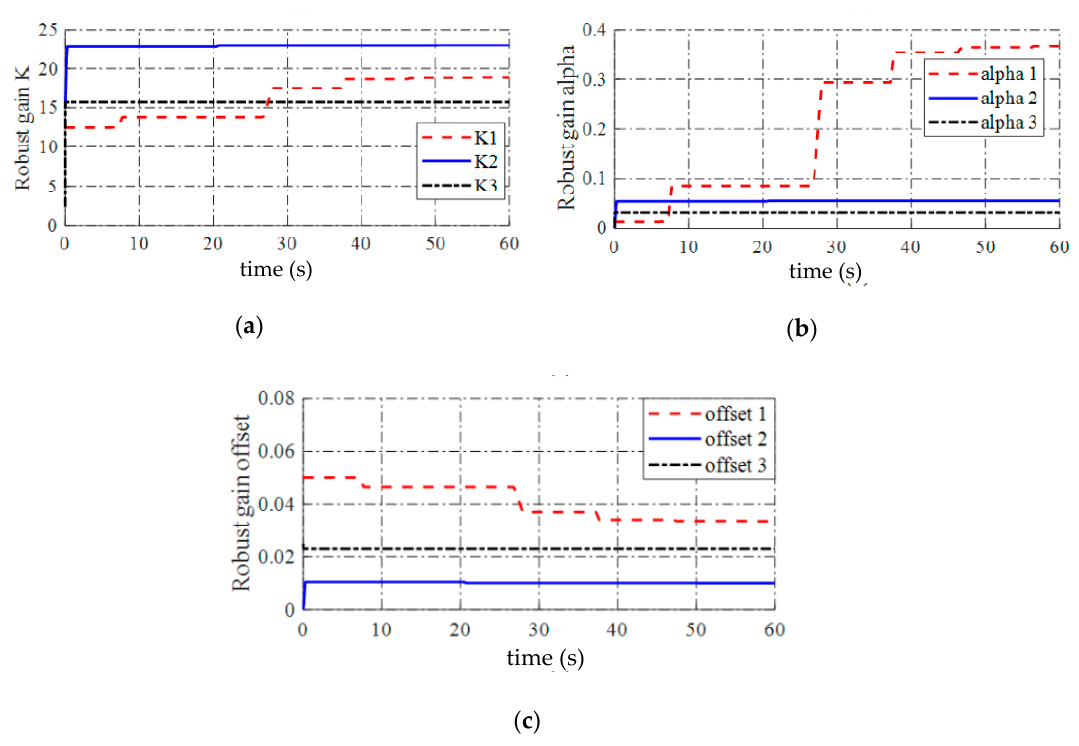
Figure 9. The adaptive gains: ( a ) Robust gain K, ( b ) α , ( c ) offset gains of i th joint, where i = 1,2,3 with respect to the first joint, the second joint, and the third joint.